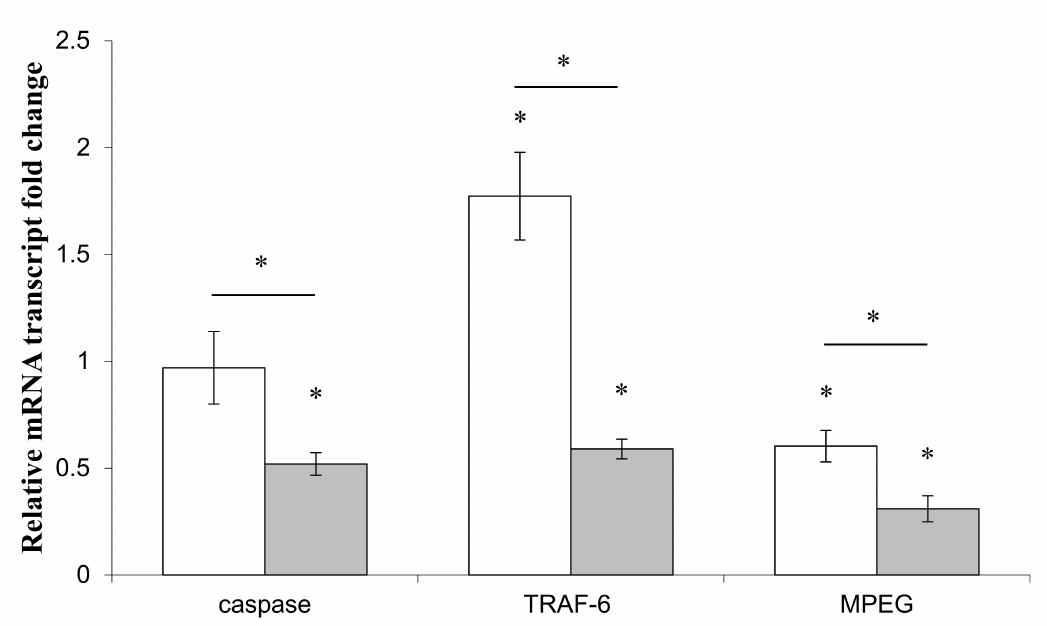
Figure 3. Expression of genes related to the immune system, MPEG and TRAF-6 and to the apoptotic pathway, caspase, in primmorphs co-incubated in the presence of 1mL / 20 mL of supernatant of the sponge-isolated bacterium Endozoicomonas sp. Hex311 ( ) or Pseudolateromonas sp. 1A1 ( ), respectively. (*) Statistical di ff erences between the controlled and the stimulated condition are materialized by an asterisk and statistical di ff erences between primmorphs stimulated by the two bacteria are materialized by a horizontal